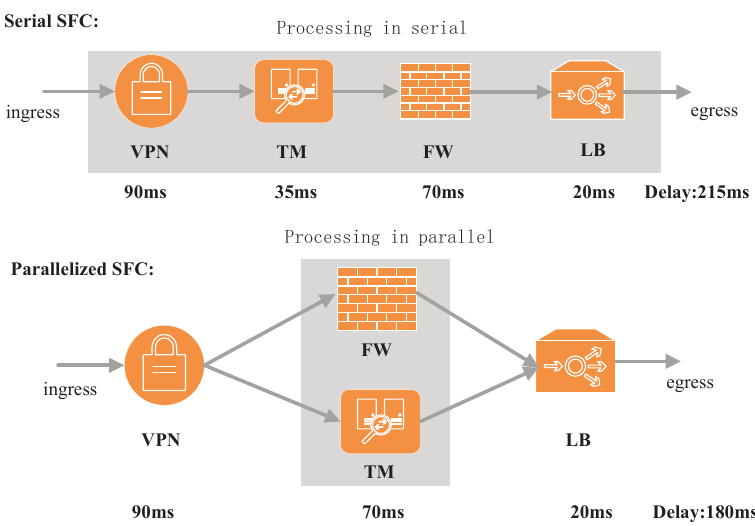
Figure 1. Serial and parallel SFC processing comparison adapted from [4]. The number below each VNF denotes the processing time of that VNF, which is derived from the tests conducted in [1]. Traffic arrives at the source node, passes through each VNF, and finally reaches the destination